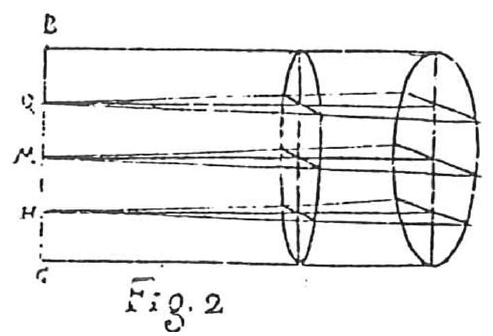
Figure 17. Architettura Civile. Camillo G. Guarini. Lastra IX. Trat. IV. Depiction of a cone ending in a line.